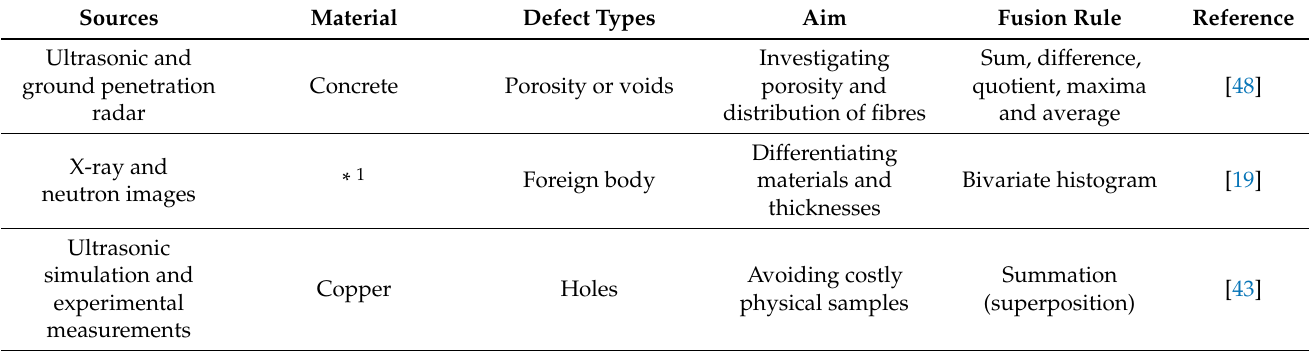
Table 2. Brief information on current studies which use general algebraic fusion